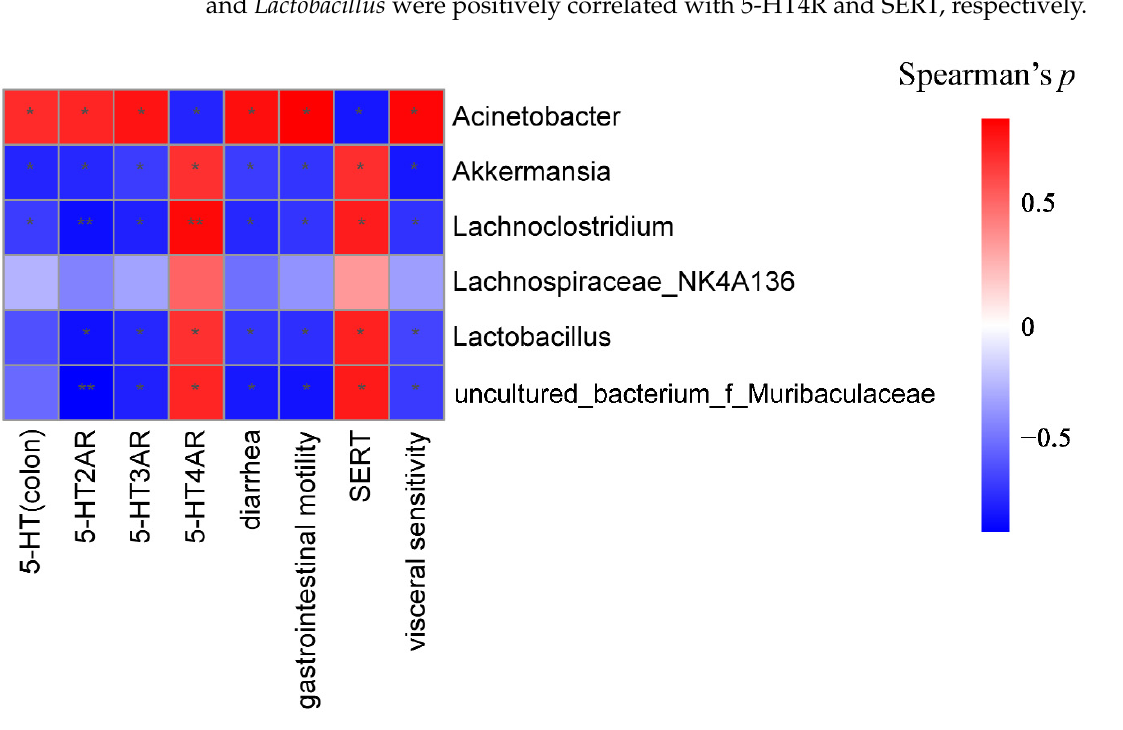
Figure 12. Association map for three-tiered analyses integrating the gut microbiome, D-IBS pheno- types and molecular biology indicator. Scale indicates the level of positive (red) or negative (blue) correlation, * p < 0.05 and ** p < 0.01.